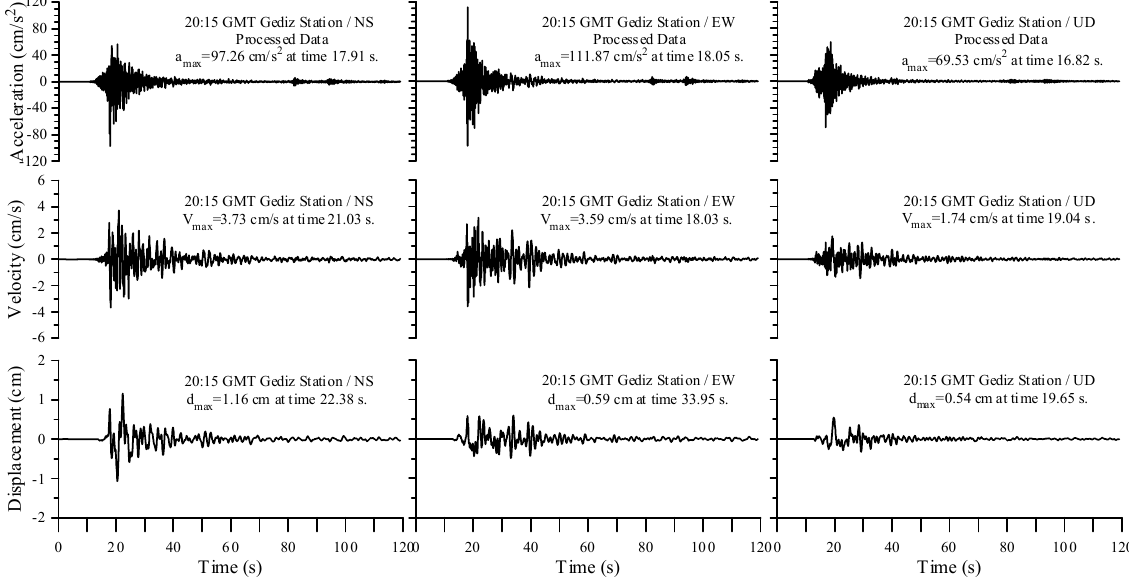
Figure 5. Acceleration, velocity, and displacement histories recorded at the Gediz Meteorology Station during the 19 May 2011 Simav (Kütahya)